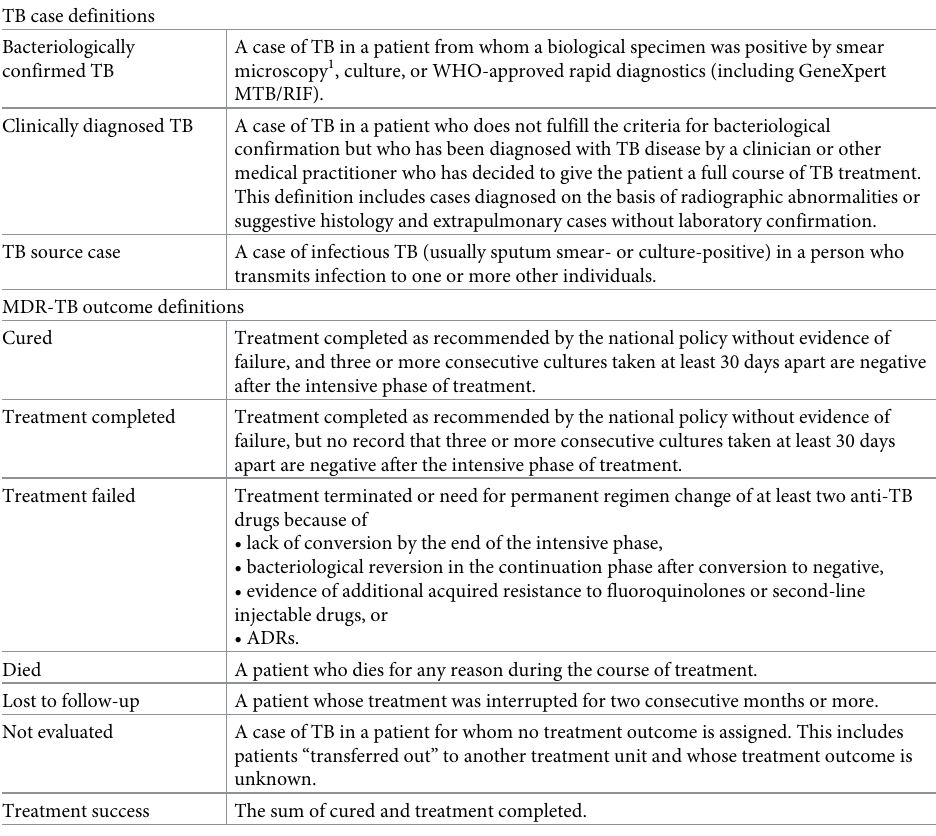
Table 1. Tuberculosis case definitions and treatment outcome